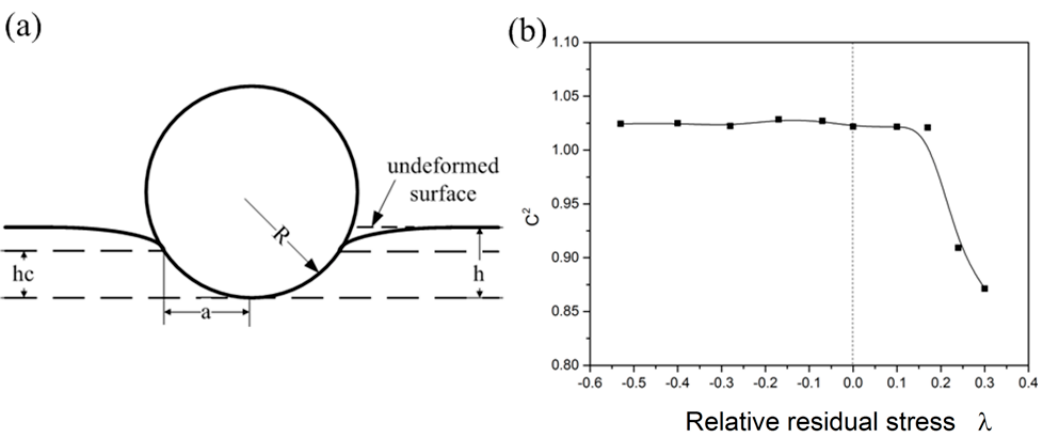
Figure 7. ( a ) A spherical indentation geometry, where a is contact radius, hc is contact depth, h is indentation depth, and ( b ) relative contact area curve versus residual stress.